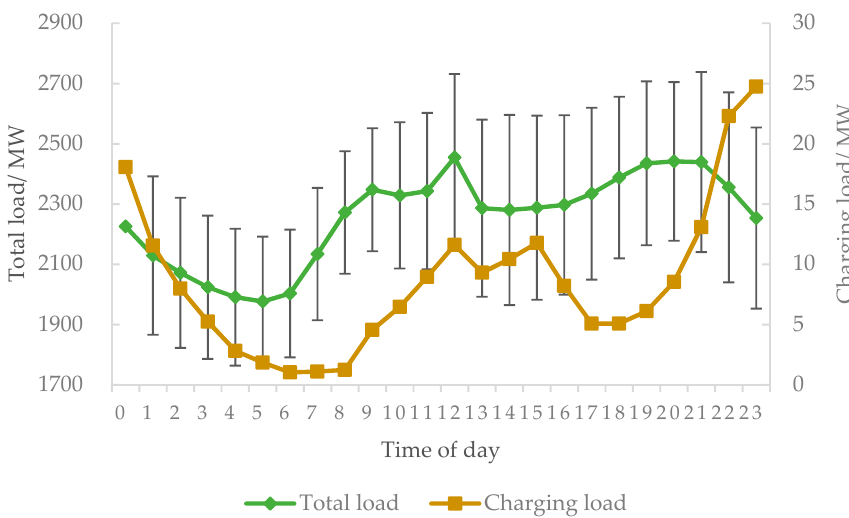
Figure 6. Electricity load chart of Hefei throughout the day. Note: The error margin is the standard deviation of the samples.